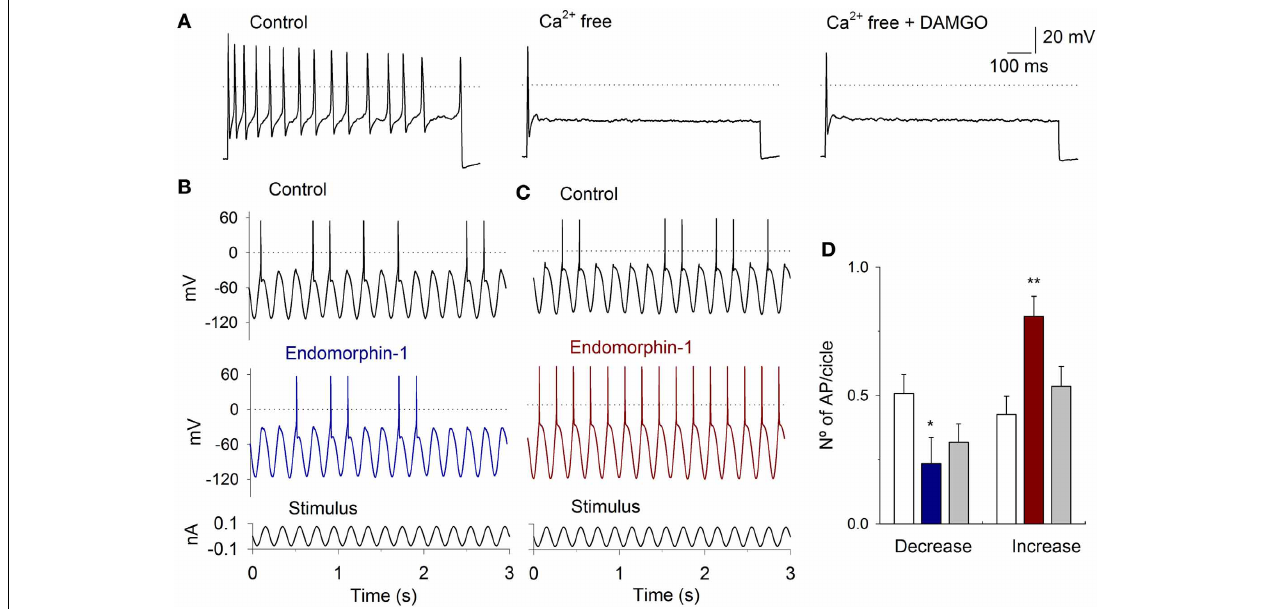
FIGURE 9 | Current clamp response to sinusoidal stimulation and MOR activation. (A) A depolarizing current pulse injection (50pA) produced a repetitive firing of the neuron The perfusion of VAN with Ca 2 + free solution significantly decreased the AP discharge, the subsequent application od DAMGO did not further modified the AP discharge. (B) Typical response to sinusoidal current injection (5Hz, 200pA,